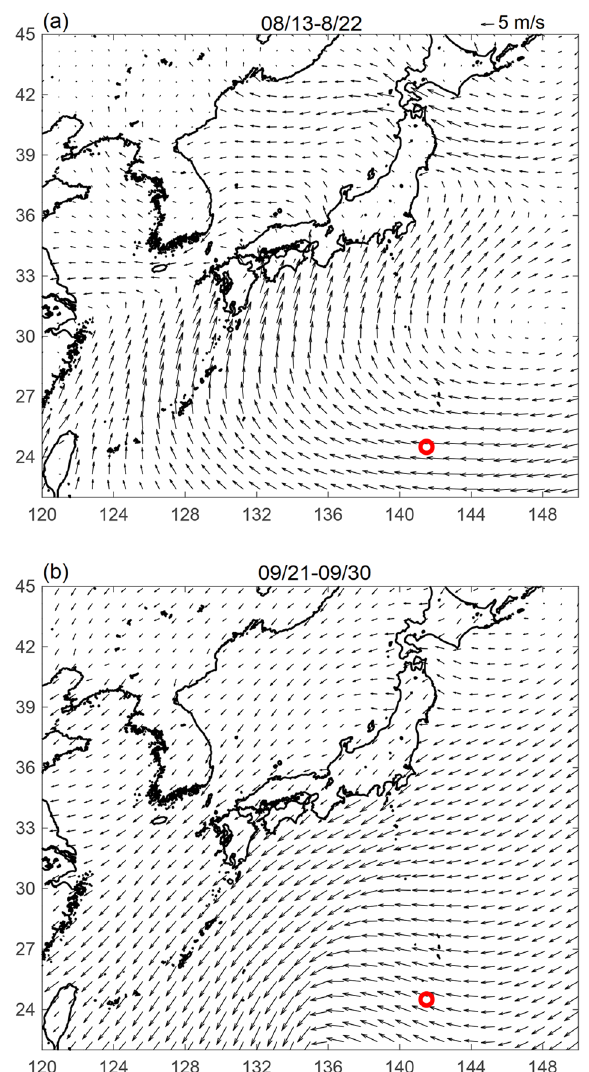
Figure 11. Average wind during ( a ) first 10 days after the eruption (13–22 August 2021), and ( b ) last 10 days of September (21–30 September 2021). Figure is created using MATLAB R2011b (http:// www. mathw orks.